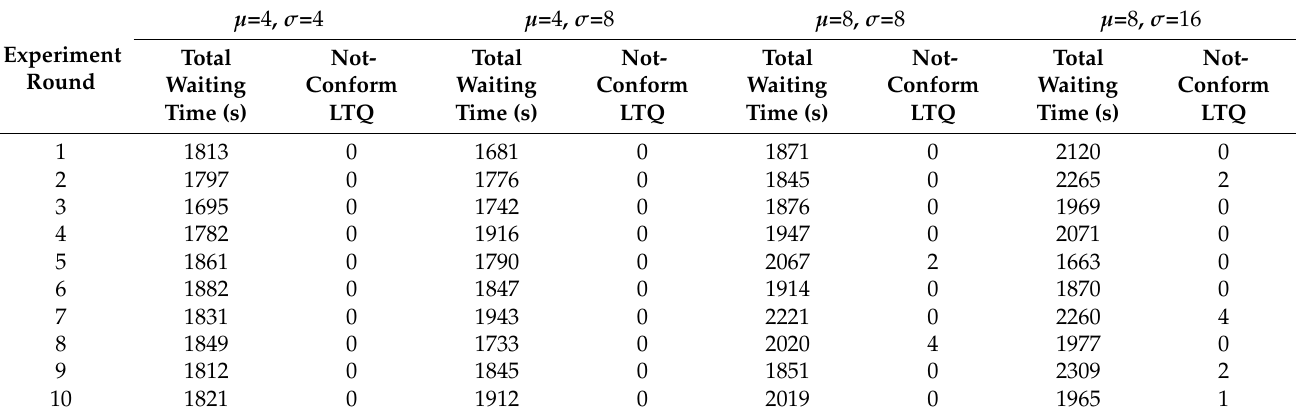
Table 12. The influence of QC conforms to different Gaussian distributions with 30 task points and 5